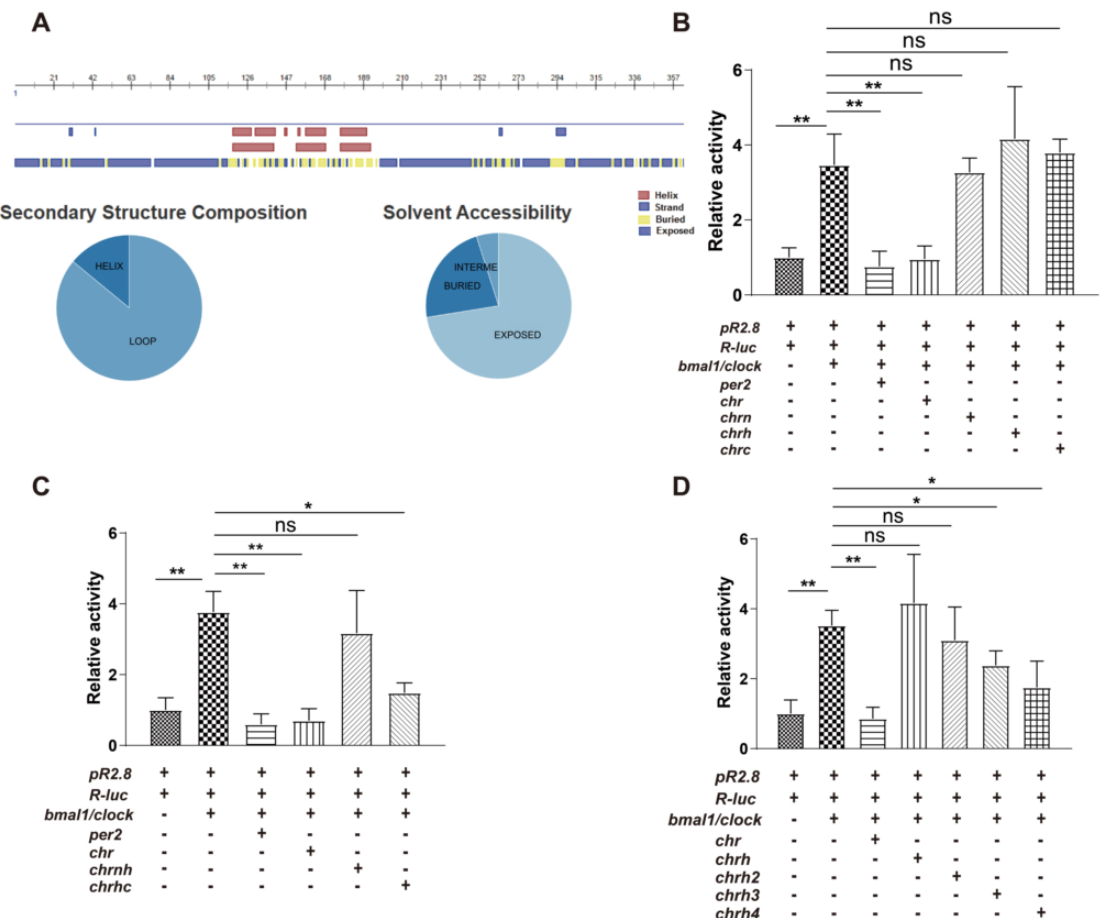
Figure 1. CHR repression domain that contains an α -helix rich region. ( A ) Predicted secondary structures show an α -helix rich region in the middle of CHR, with flexible regions in the N- and C- termini. Pie charts show that CHR containing a large proportion of flexible composition and a lot of regions are exposed. ( B ) Based on predicted secondary structures, CHR was divided into 3 separate parts: CHRN (1–110), CHRH (111–196), and CHRC (197–385). In the classical luciferase reporter assay which uses B/C complexes to activate an E-box containing promoter (pR2.8 in this experiment), each individual part of CHR lost the repressive activity of CHR. ( C ) However, the combination of the predicted helix region plus the C-terminus (CHRHC, 111-385) is able to function as a repressor, rather than the combination of the helix region plus the N-terminus (CHRNH, 1-196). ( D ) Luciferase assays indicate that CHRH plus extended regions at its C-terminus (CHRH3, 111–264 and CHRH4, 111–298) could repress the transcription activation by B / C complexes. Since CHRH3 is 2 amino acids longer than CHRH2 that did not perform the repressive function, this indicates that the helix containing H3 is the minimal domain that functions as a repressor to B / C complexes. At least three independent experimental repeats were done for each luciferase reporter assay. Graphpad Prism 5 was used to generate graphs / plots and perform statistical analysis (2-tailed unpaired t-test). ns, no significance; * p < 0.05; ** p < 0.01.